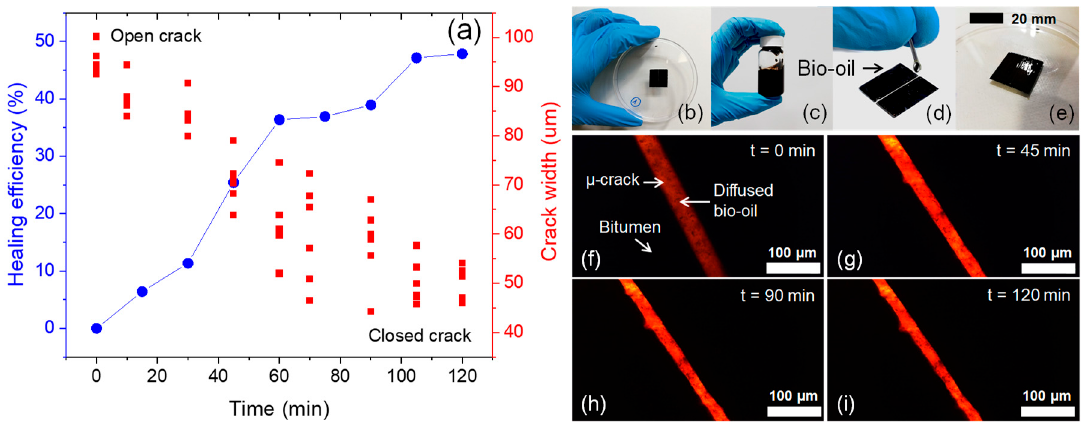
Figure 11. ( a ) Results of healing efficiency and µ-crack with over time; ( b–e ) Procedure to measure the healing efficiency of BO on film bitumen test samples of 20 × 20 × 0.5 mm; ( f–i ) Fluorescence microscopy images on closed µ-crack by the effect of BO diffused in bitumen over time.